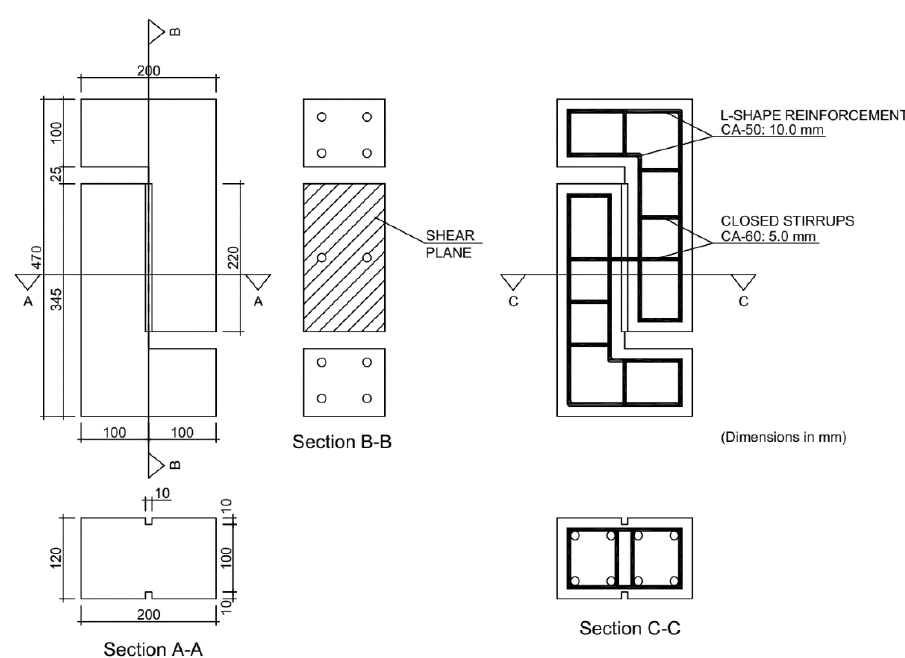
Figure 1. Specimens dimensions and reinforcement details.